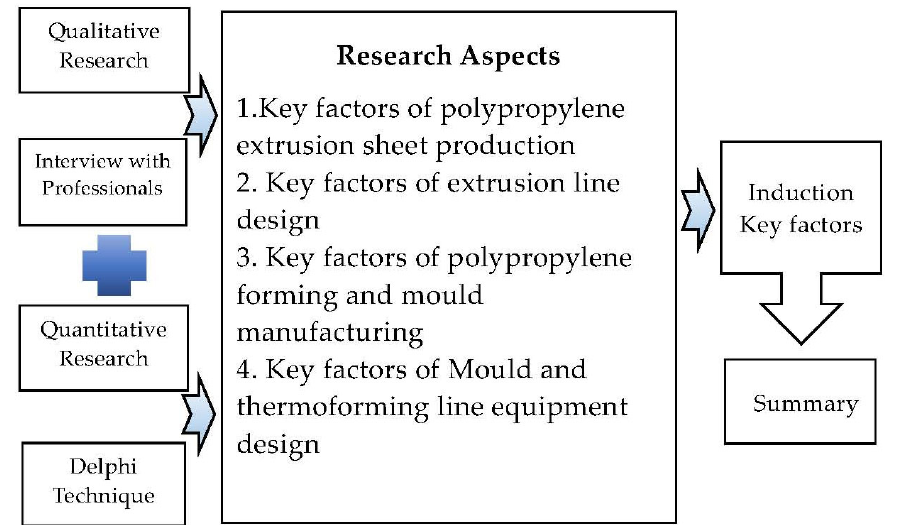
Figure 5. Research Figure 5. Research structure.